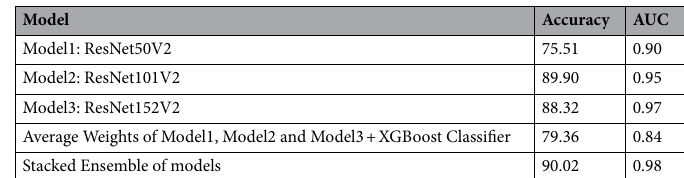
Table 12. Shape classification results on the CBIS-DDSM